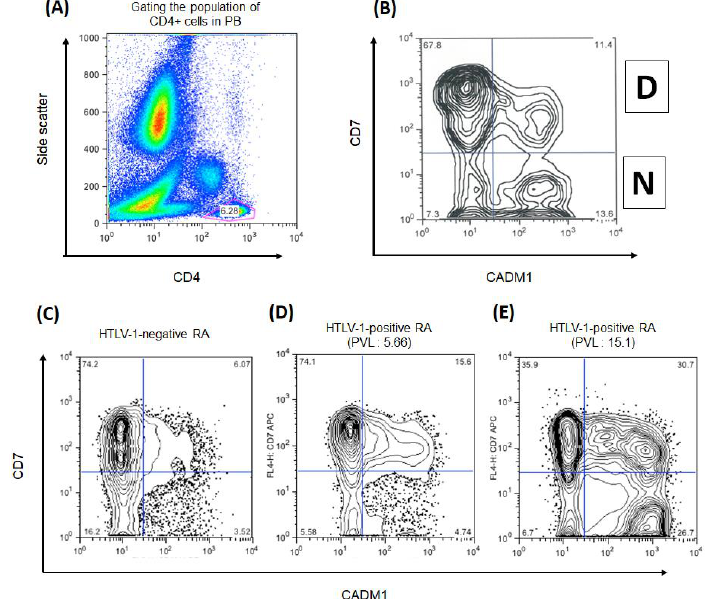
Figure 1. The representative data of CADM1 versus CD7 plot in CD4+ cells in participants with rheumatoid arthritis (RA). ( A ) The gating of the CD4+ cell population in peripheral blood (PB). ( B ) CADM1 versus CD7 plot of CD4+ T-cell population. Upper-right and lower-right regions were named D and N, following previous study. The CD4+ T-cells in D and N region are human T-cell leukemia virus type 1 (HTLV-1)-infected cells. ( C – E ) The CADM1 versus CD7 plot in CD4+ cells in HTLV-1-negative RA patient, HTLV-1-positive RA participants with different proviral loads (PVLs). The HTLV-1 PVL were 5.66 and 15.1 copies/100 peripheral blood mononuclear cells, respec- tively.